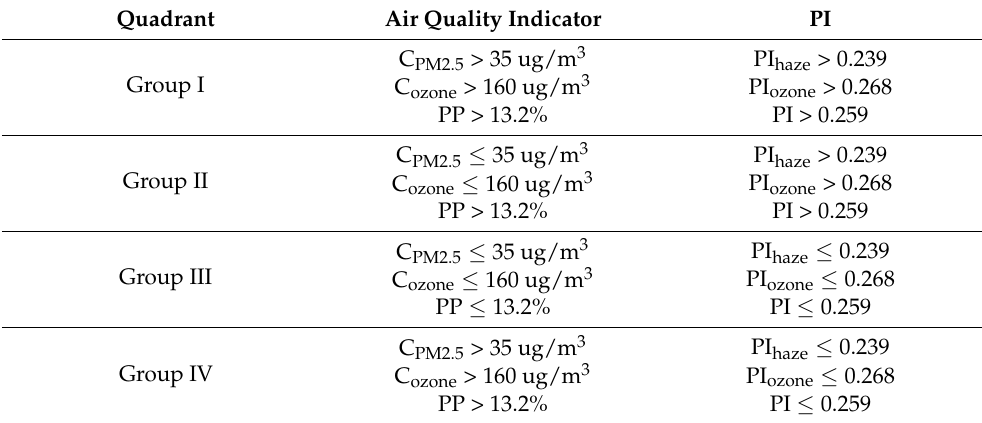
Table 3. Classification principles based on urban air quality and